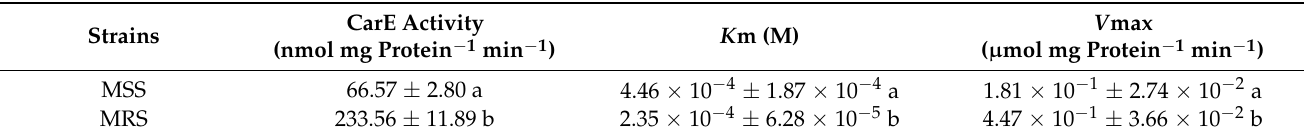
Table 4. Carboxylesterase activity and kinetic parameters in S. miscanthi .